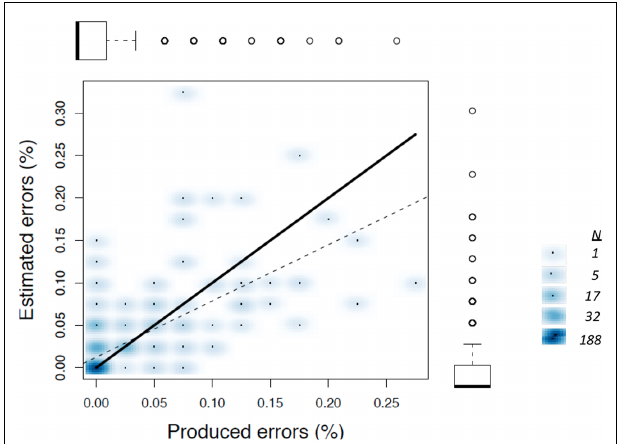
FIGURE 4 | Smoothed scatterplot showing the relationship beween produed and estimated errors within the normal feedback condition from Experiment 1. Boxplots aligned with each axis show frequency distributions, with outliers shown as open circles. Estimates from all individual trials are plotted ( N = 352). Unity is shown by the dark line, and the best-fitting least squared regression is shown by the dashed line.The legend on the right highlights frequency counts associated with selected